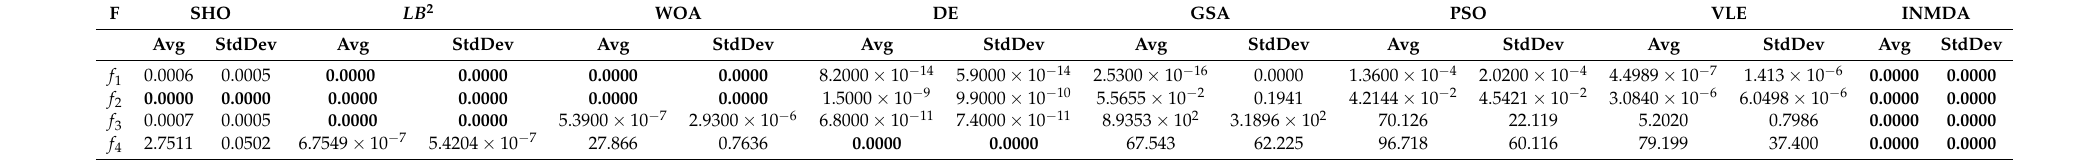
Table 6. Results comparison in unimodal benchmark functions.